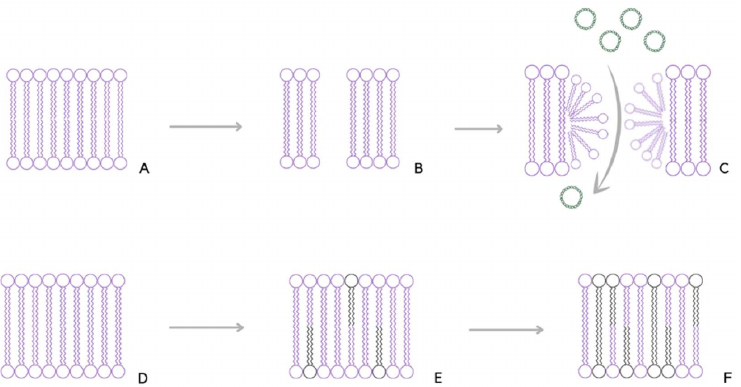
Figure 1. Schematic visualization of molecular mechanism in which plasma membrane permeability is changed due to electric stimulus, allowing genes to be transferred to the intracellular environment. A change of the physiological voltage ( A ) induces the formation of indentation and then transient hydrophobic pores, the diameter of which ranges from 2 to several nanometers ( B ). Hydrophobic pores are transmutable to hydrophilic ones by reorienting polar headgroups of lipids towards water molecules. In this way, plasmid DNA can enter the intracellular environment ( C ). The electric stimulus also influences single membrane lipids properties by inducing chemical variations, such as peroxidation, deforming lipid tails, and therefore increasing the permeability of the plasma membrane ( D – F )